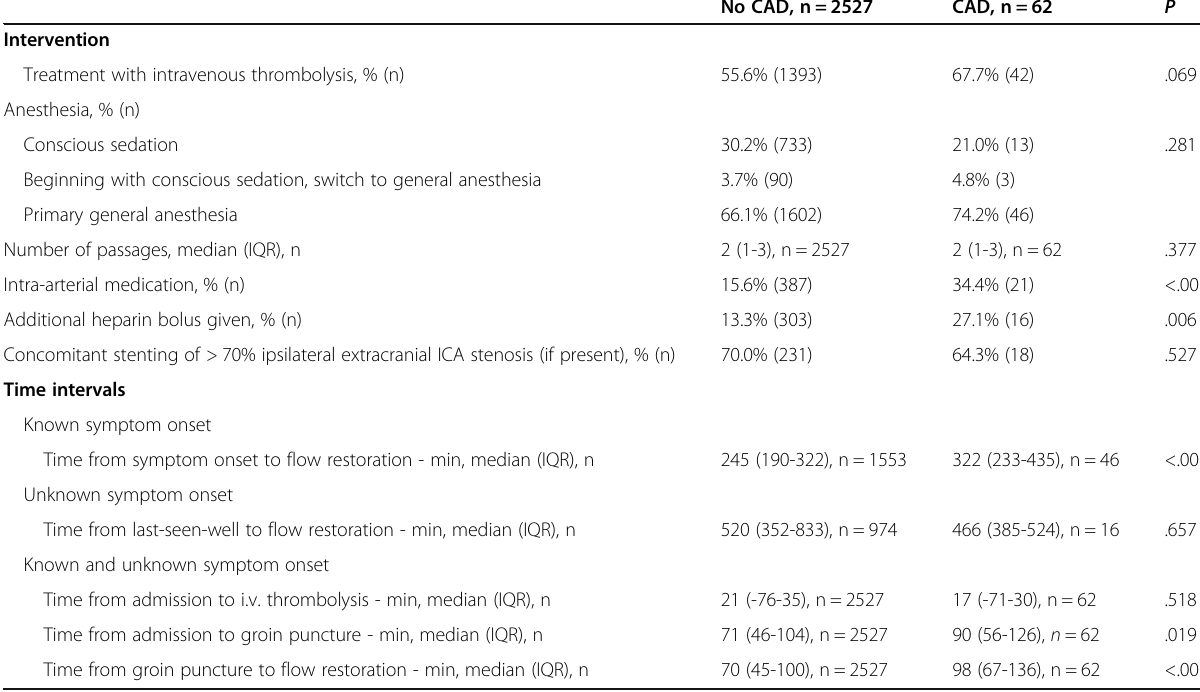
Table 2 Procedural